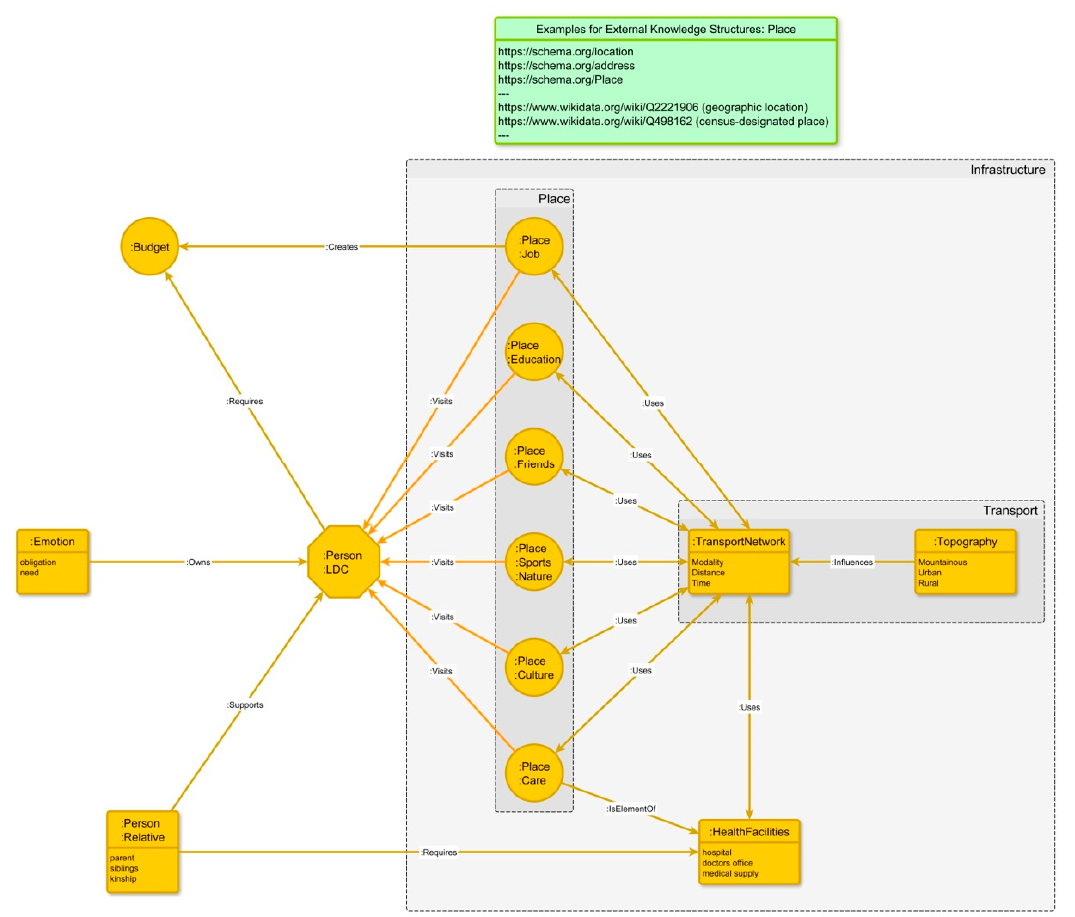
Figure 2. A graph model concept based on long-distance caregiving ontology—including the knowledge graph of a single case study, its most relevant spatial clusters (place, transport, infrastructure), and an exemplary embedding into existing knowledge structures, like schema.org, Wikidata, dbpedia, etc. (on the top of the figure). Own illustration.